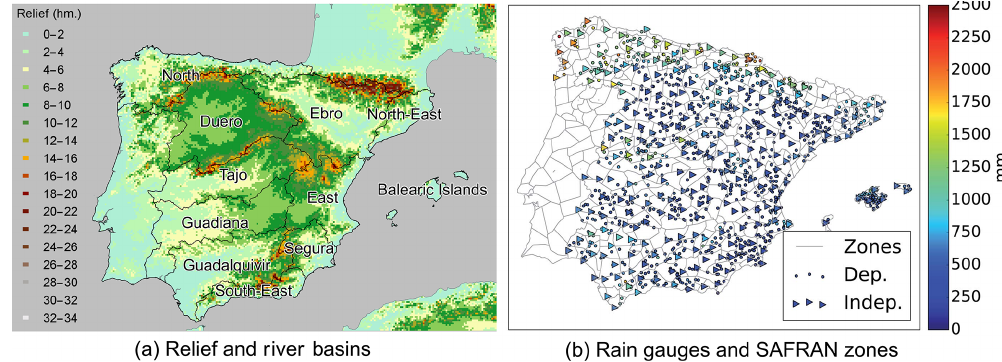
Figure 1. Maps of the study area. The left panel shows the relief (using the same 5km resolution grid that SAFRAN uses) and the main river basins in Spain (note that for the sake of simplification, some of the smaller river basins have been grouped). The right panel shows SAFRAN’s climatically homogeneous zones, the rain gauges used for the study and their mean yearly precipitation. The dependent and independent stations are shown as dots and triangles,